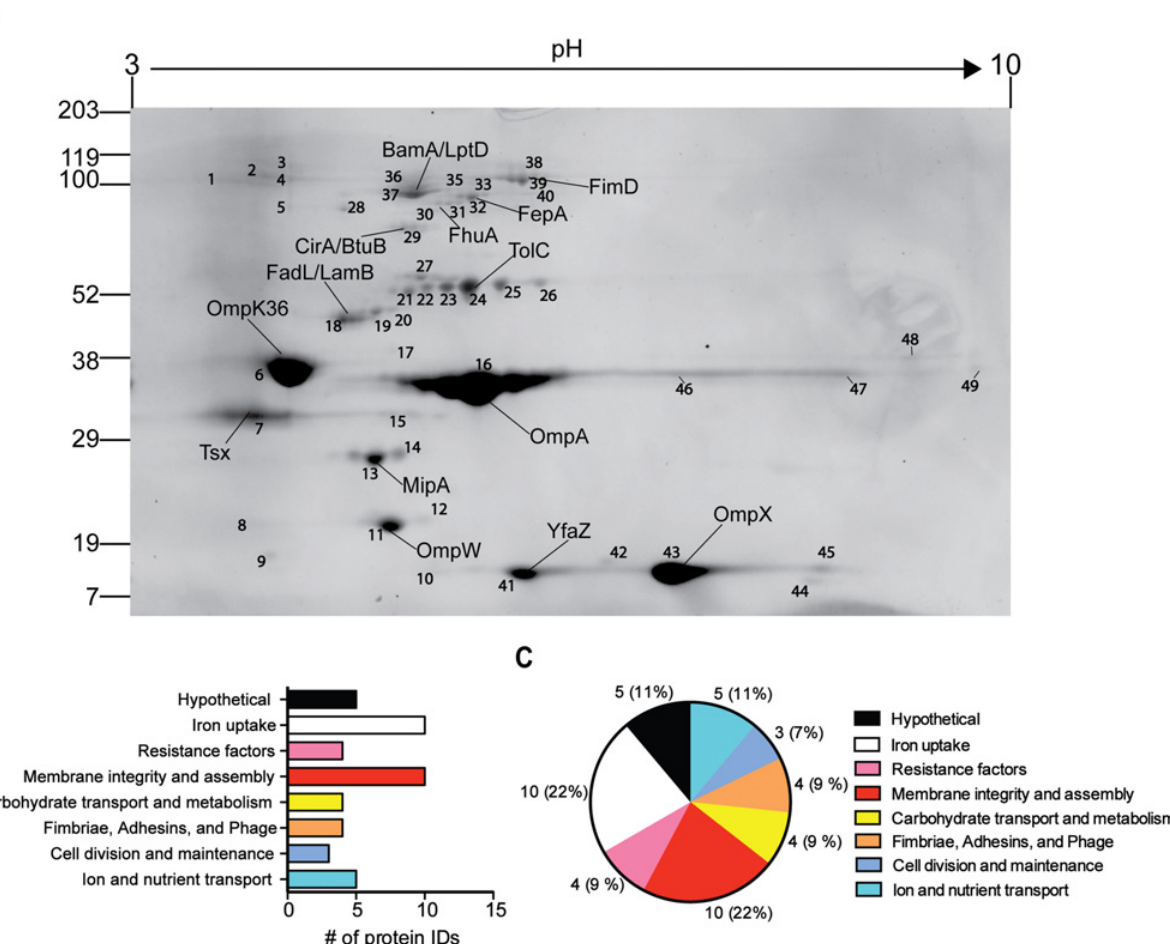
Fig 3. Identification of K . pneumoniae outer membrane proteins by 2DE. (A) Two-dimensional map of outer membrane proteins from isolate 30660 cultured to stationary phase of growth in LB. Numbers refer to the extracted spots that were processed for identification by LC-MS/MS. The pI and molecular weight markers are shown on the top and right, respectively. (B) Categorical representation by function of predicted outer membrane proteins. (C) Categorical representation by function of predicted outer membrane